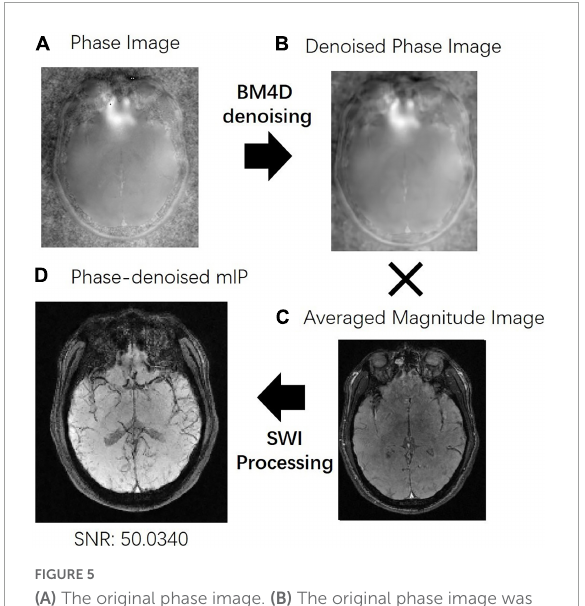
(C) The average magnitude image of the last three echoes. (D) The averaged magnitude image and the denoised phase image were applied to the susceptibility weighted imaging (SWI) processing to improve the signal-to-noise ratio (SNR) of the result.